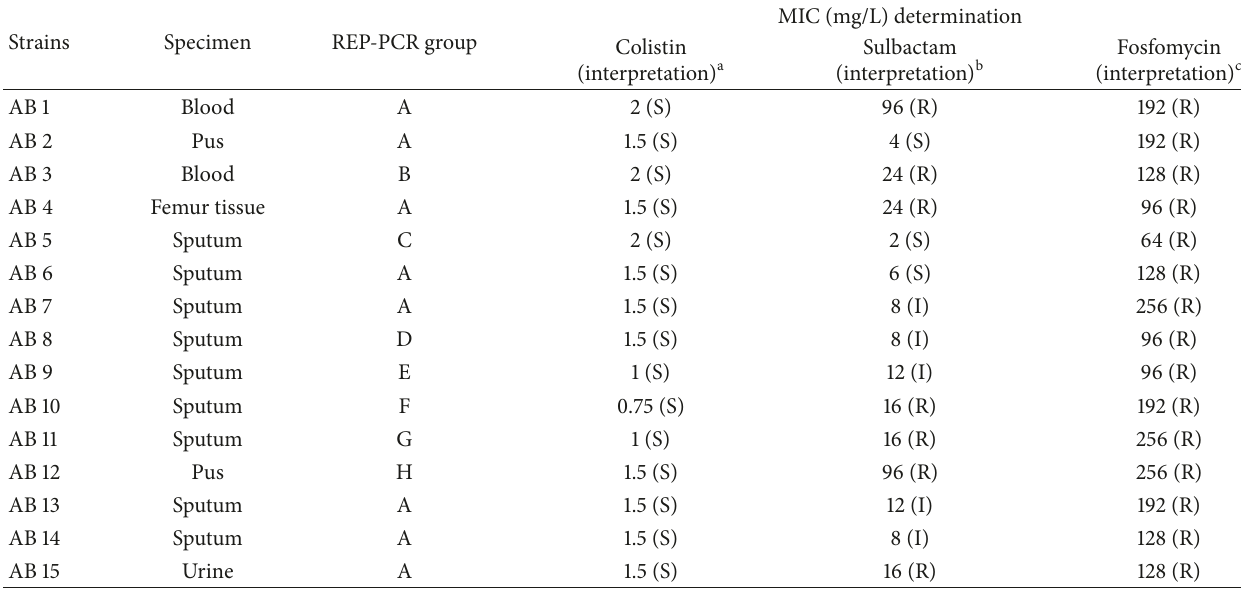
Table 1: Minimum inhibitory concentration (MIC) determination by E-test and susceptibility interpretation of colistin, sulbactam, and fosfomycin against carbapenem-resistant A. baumannii isolates. Strains Specimen REP-PCR group